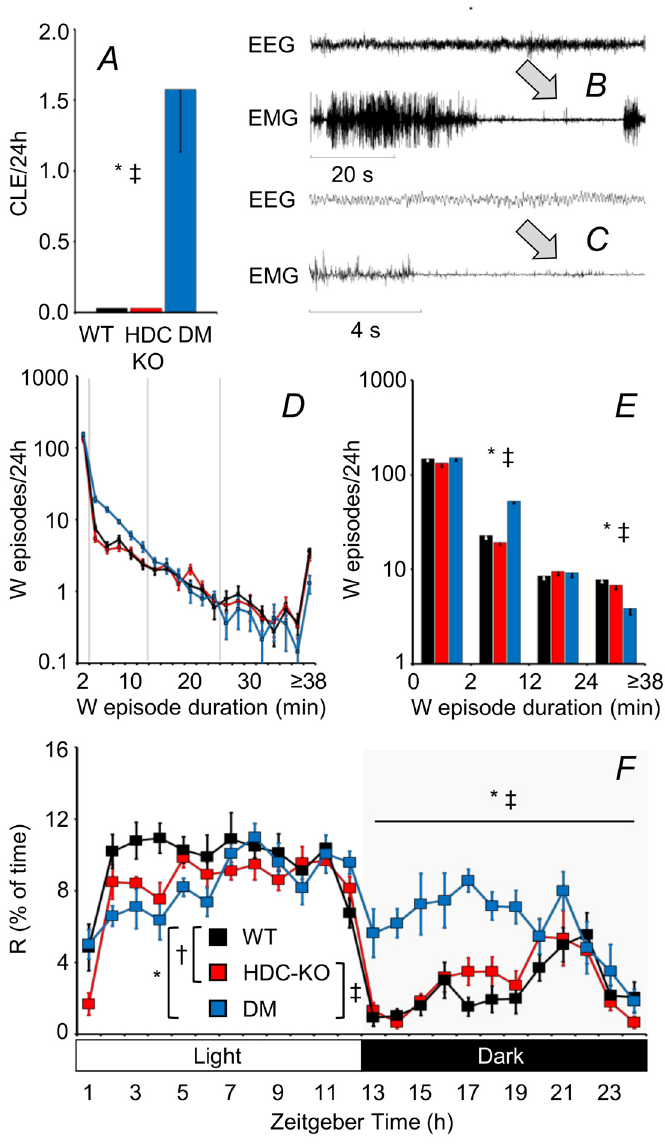
Fig 2. Cataplexy and sleep-wake derangements. (A) Frequency of occurrence of cataplexy-like episodes (CLE) during the dark period. In this and the remaining panels, data are means ± SEM in HDC-KO (n = 11), DM (n = 7), and WT (n = 11). (B) Representative raw tracings (EEG, electroencephalogram; EMG, electromyogram) showing a CLE (arrow) in a DM mouse. Details of the transition between wakefulness (W) and this CLE are shown in (C), evidencing an almost complete drop in neck muscle tone with preservation of the theta frequency rhythm of the preceding episode of W. (D) Frequency of occurrence of W episodes as a function of their duration. The distribution of W durations was significantly different between HDC-KO, DM, and WT (P < 0.001, Kolmogorov-Smirnov test). The bar graphs in (E) show the frequency of occurrence of W episodes in four arbitrary bins of W episode duration. (F) Percentage of recording time spent in rapid-eye- movement sleep (R). The horizontal bar refers to the whole dark period. * , † , and ‡ , P < 0.05, WT vs. DM, WT vs. HDC-KO, and HDC-KO vs. DM, respectively (t-tests).